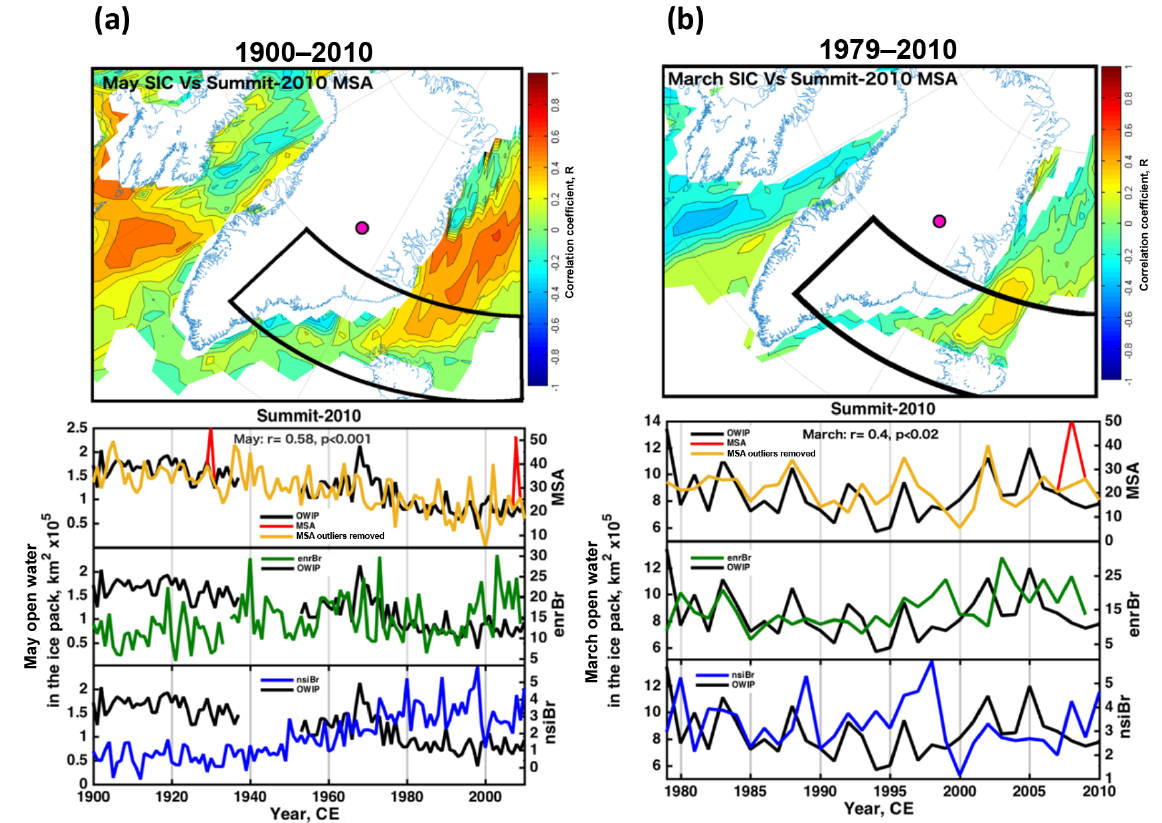
Figure 6. Upper panels: correlation map of monthly sea ice concentration (SIC) derived from the Summit-2010 ice core. The SIC map corresponds to the month which shows the highest OWIP correlation (lower panels) with the annual MSA. Other monthly maps are shown in Fig. S9. (a) HadISST1 ICE dataset from 1900 to 2010CE correlated with annual records of MSA (with outliers removed). Only locations that showed a SIC variability greater than 10% and have a significant correlation ( t test, p < 0.05) are displayed. The area of sea ice that is the likely source of MSA (as indicated by the air mass trajectories) are outlined in black (70–63 ◦ N, 0–45 ◦ W). (b) As for (a) but focused on the satellite period 1979–2010CE. Lower panels: the correlation between the area of open water within the ice pack (OWIP) calculated within the black outlined areas shown on the upper maps and the annual MSA records (red) with outliers removed (orange) in nM. Summit- 2010 MSA shows a significant, positive correlation with the amount of OWIP during spring within the integrated regions over both time periods. The highest correlations were found for March over the 1979–2010 period and May for the 1900–2010 period. In (b) if the MSA source region is enlarged to (70–63 ◦ N, 0–60 ◦ W) the March OWIP–MSA correlation increases slightly (from 0.38 to 0.4). The Summit-2010 enrBr(Na) and nsiBr records (in nM) are also compared to the same OWIP records. Particularly over the longer time period, there is little correlation between the